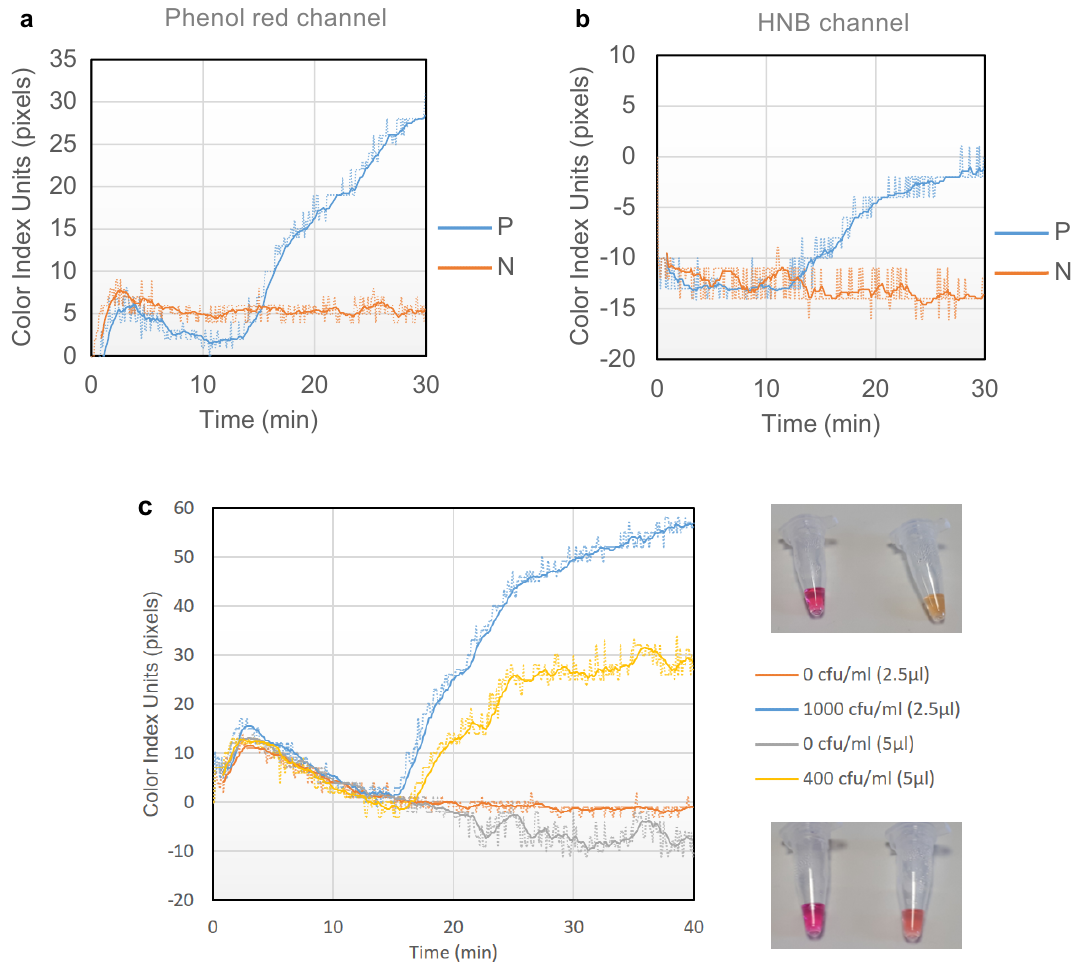
Figure 2. ( a ) Real-time colorimetric LAMP reactions performed inside the device using the phenol red indicator. The positive reaction (blue line) contained 10 lysed bacteria as template while the negative control contained no bacteria (orange line). ( b ) Similar reactions to ( a ), this time performed with the HNB indicator. In both cases, the heating process started at t = 0 min and the heater reached the required temperature (63 °C) after approximately 2 min. All reactions were stopped after 30 min. ( c ) Left: Real time colorimetric curves monitored during qcLAMP amplification performed with 2 different bacteria concentrations (400 and 1000 CFU/ml) spiked in saliva samples. The two concentrations were chosen based on previously reported detection limits of bacteria using end-point colorimetric LAMP or biosensors (13, 54). Both were successfully detected in less than 17 min while zero background signal was monitored for the negative controls. Right, top: Picture of end-point reactions with 0 and 1000 CFU/ml after 40 min of incubation. Right bottom: Picture of end-point reactions with 0 and 400 CFU/ml after 40 min of